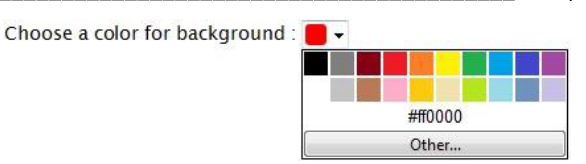
Fig. 10. Choice of color with use of Opera web-browser standard